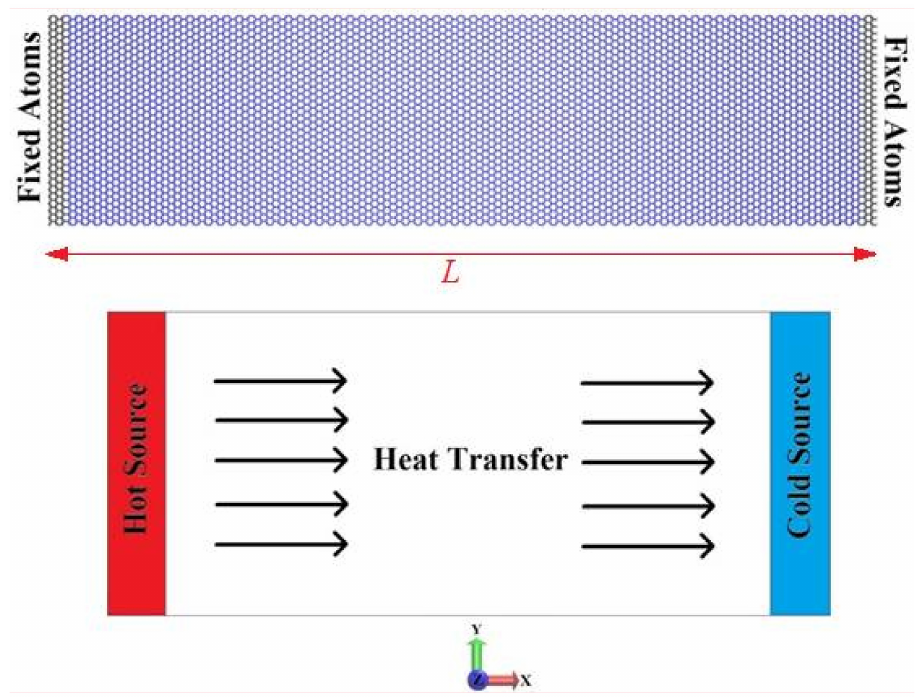
Figure 1. The schematic model for the evaluation of the thermal conductivity of single-layer h-BN and Graphene films with L (denotes the length) ranging 33 to 140 nm.